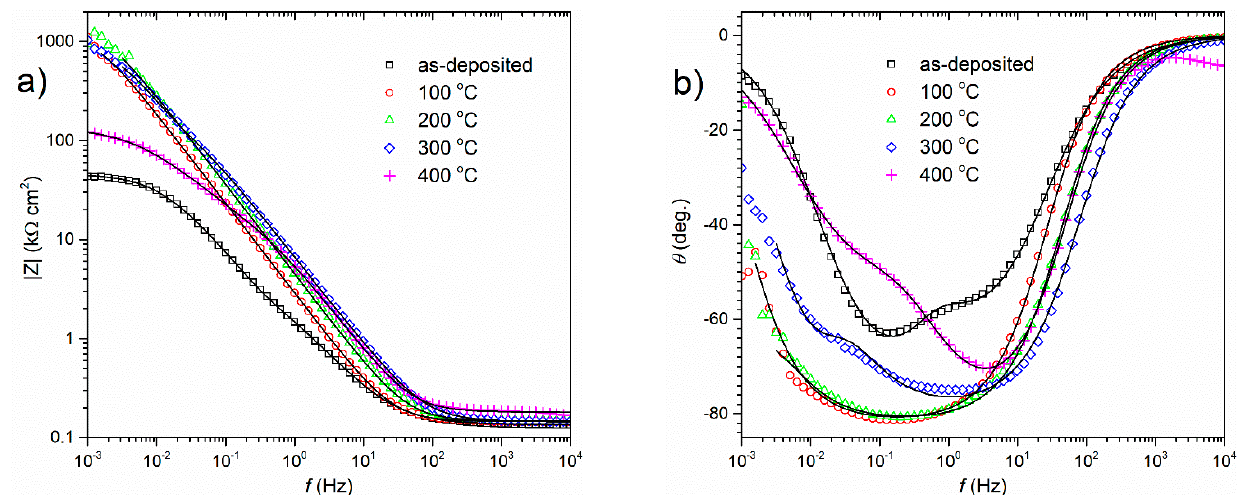
Figure 9. Bode plot of impedance spectra recorded after 168 h exposure in 0.05 mol dm − 3 NaCl for the as-deposited and heat-treated nickel coatings for 2 h at: 100; 200; 300 and 400 °C. Frequency dependence of the impedance modulus ( a ) and the phase angle ( b ).